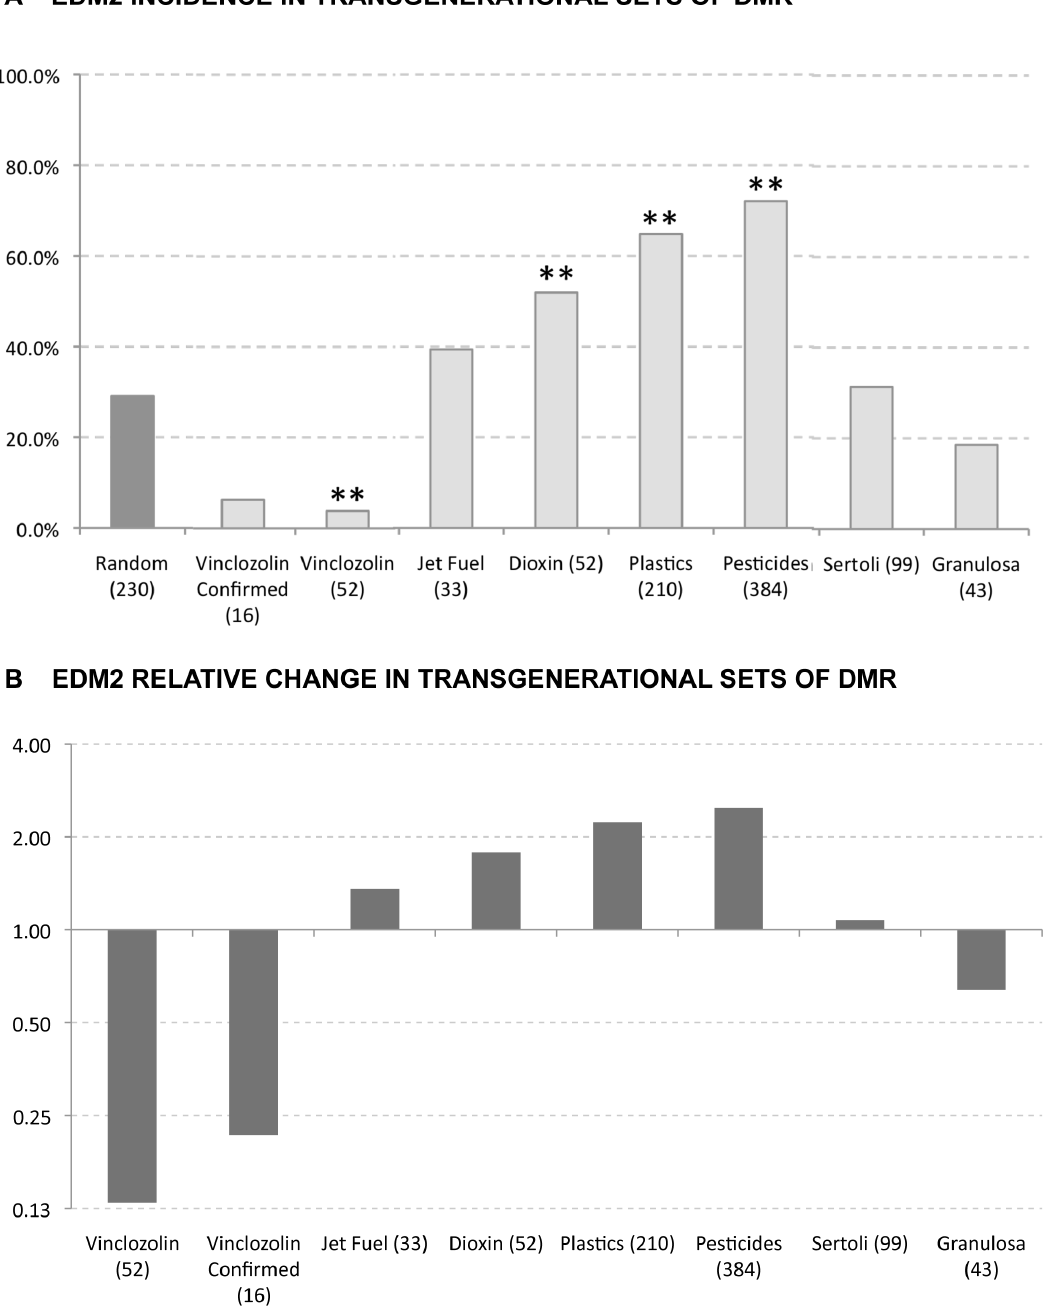
Figure 3. EDM2 incidence in exposure epimutation data sets. (A) Individual occurrence (percentage) of EDM2 in a variety of sets with transgenerational DMR and (B) relative change of EDM2 in these DMR. Columns with ** represent significant change with p , 0.01, while columns with * represent significant change with p , 0.05.